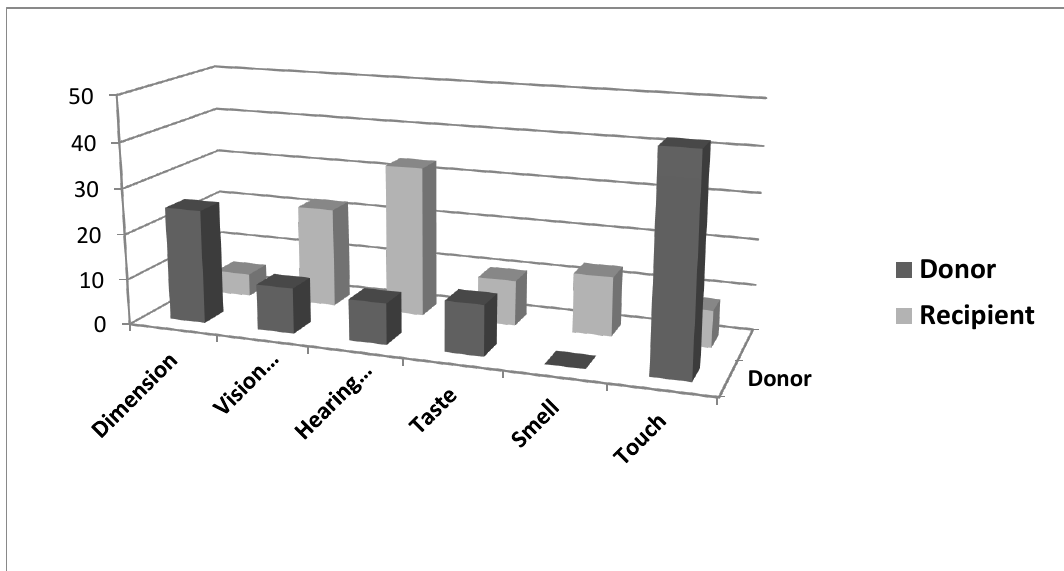
Fig. 2. – Total number of produced and received metaphors for each sensor in the Italian language (five senses plus Dimension Zone)